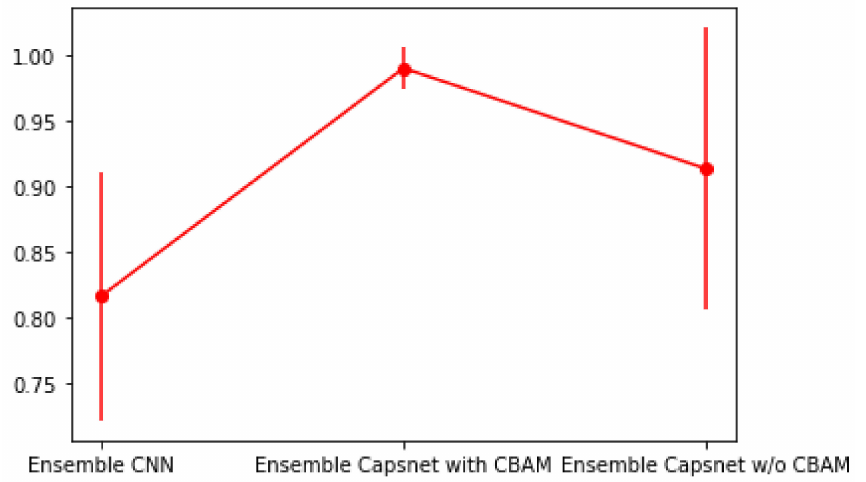
Figure 13. The diagnostic accuracy, mean and variance, of three different diagnostic